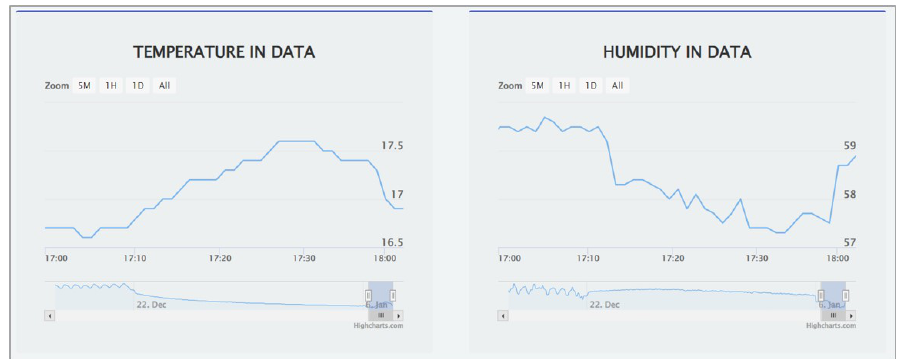
Figure 3. Table of sensor data.